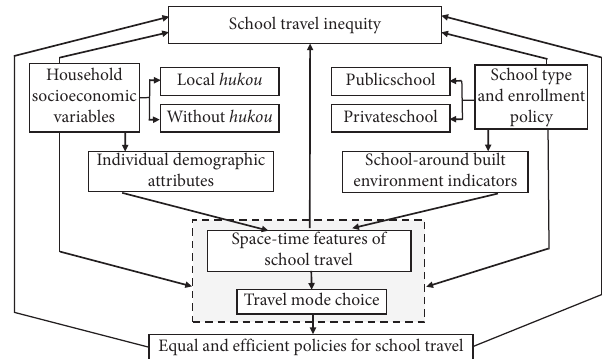
Figure 1: Conceptual framework for exploring school travel